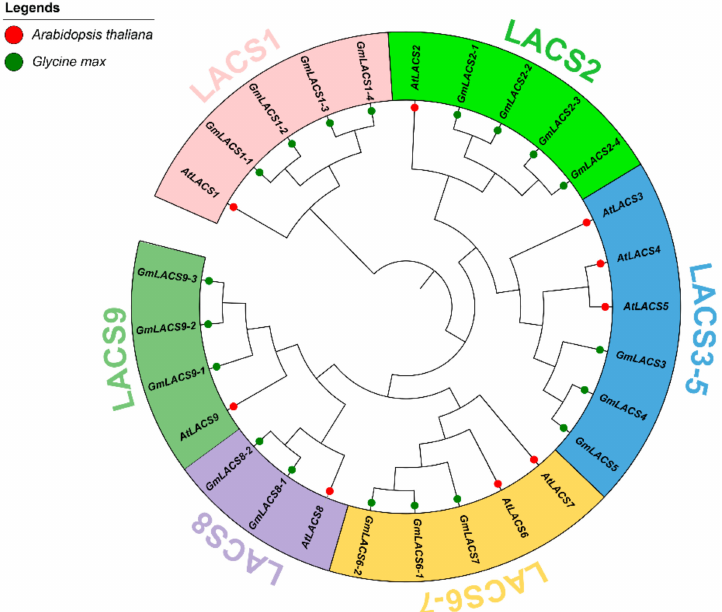
Figure 1. Maximum likelihood phylogenetic tree of the LACS gene family from Glycine max and Arabidopsis thaliana